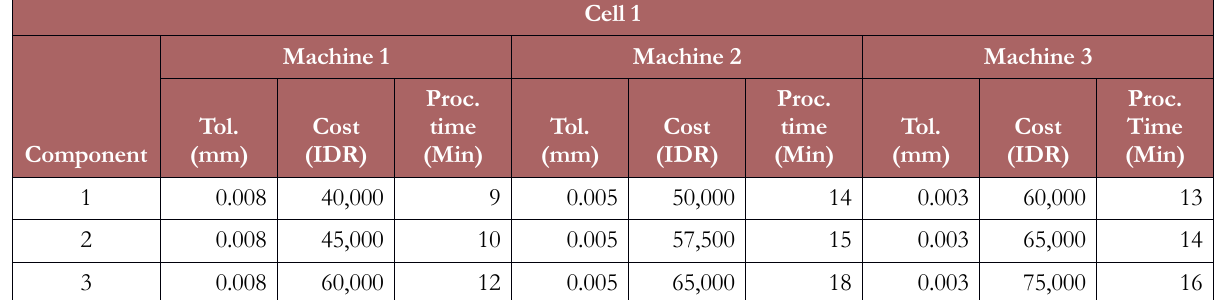
Table 1. Machine characteristics in Cell 1